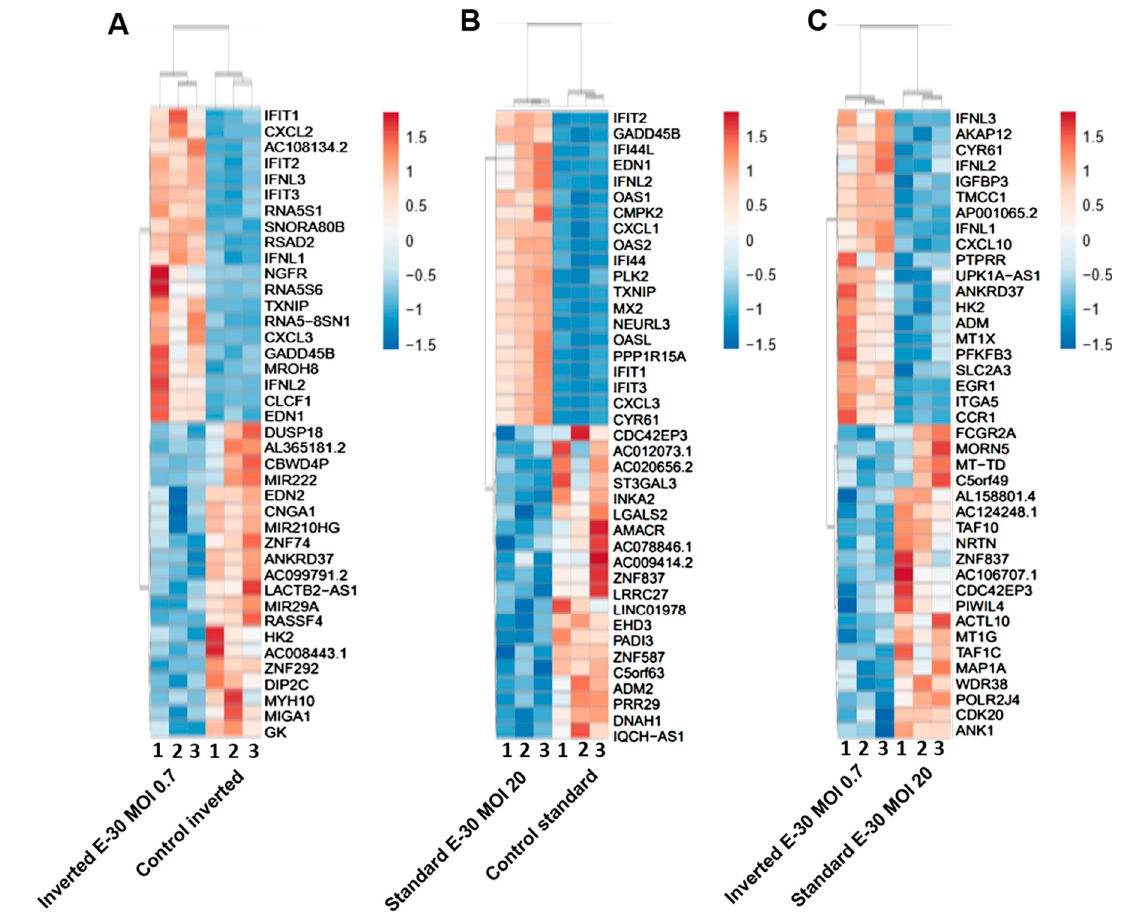
Figure 7. Polar E-30 infection of HIBCPP cells has a differential impact on HIBCPP cells’ RNA. Heatmaps representing the first 20 upregulated (in red) and 20 downregulated genes (in blue), in inverted culture infected with E-30 MOI 0.7 versus inverted control ( A ), standard culture infected with E-30 MOI 20 versus standard control ( B ), inverted culture infected with E-30 MOI 0.7 versus standard culture infected with E-30 MOI 20 ( C ). This resulted in a p -value and log2-fold change (log2FC) for every gene for the 3 experiments. Genes with p < 0.05, and a │ log2FC │ > 1 were considered as differentially expressed. Statistical analysis was performed using the R programming platform using the DeSeq2 R/Bioconductor package.